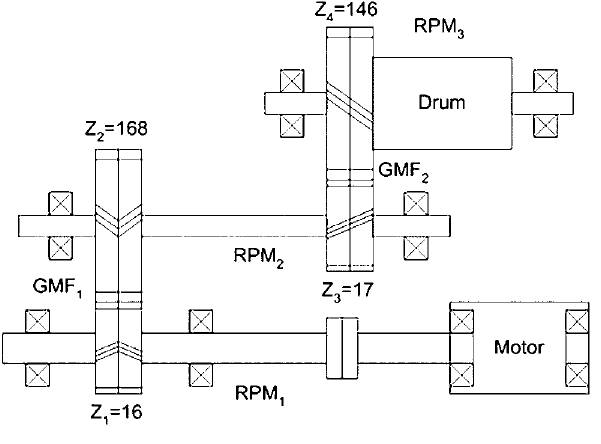
Fig. 20. Scheme of the shovel transmission.